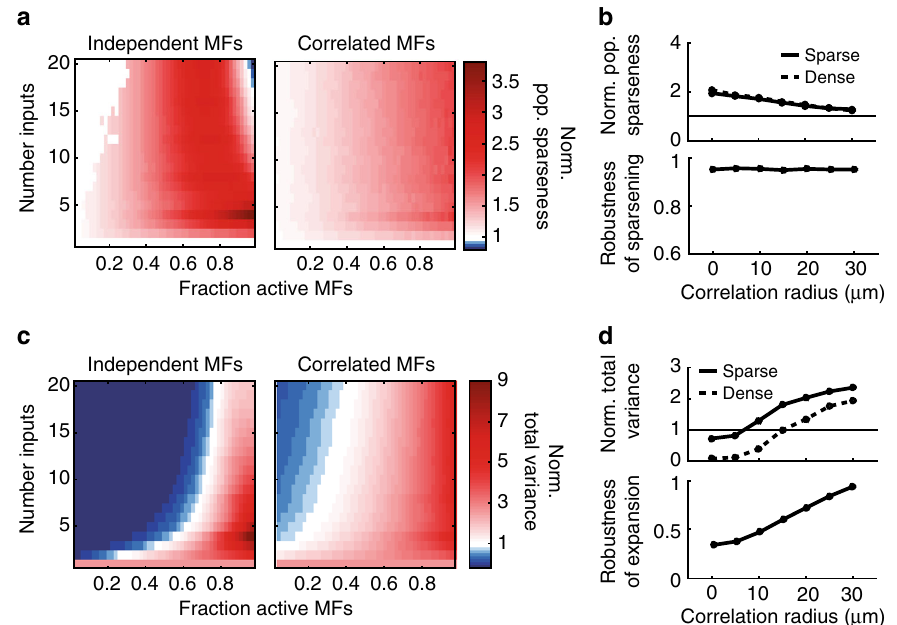
Fig. 2 Cerebellar input layer sparsens and expands input activity patterns. a Normalized population sparseness (granule cell sparseness/mossy fi ber sparseness) for independent mossy fi ber (MF) activity patterns (left) and correlated MF inputs (right, σ = 20 μ m). b Top: Median normalized population sparseness for sparse (solid line, N syn = 4) and dense (dashed line, N syn = 16) synaptic connectivities, plotted against correlation radius. Bottom: Robustness of population sparsening for different correlation radii. c , d Same as a , b plotted for normalized total